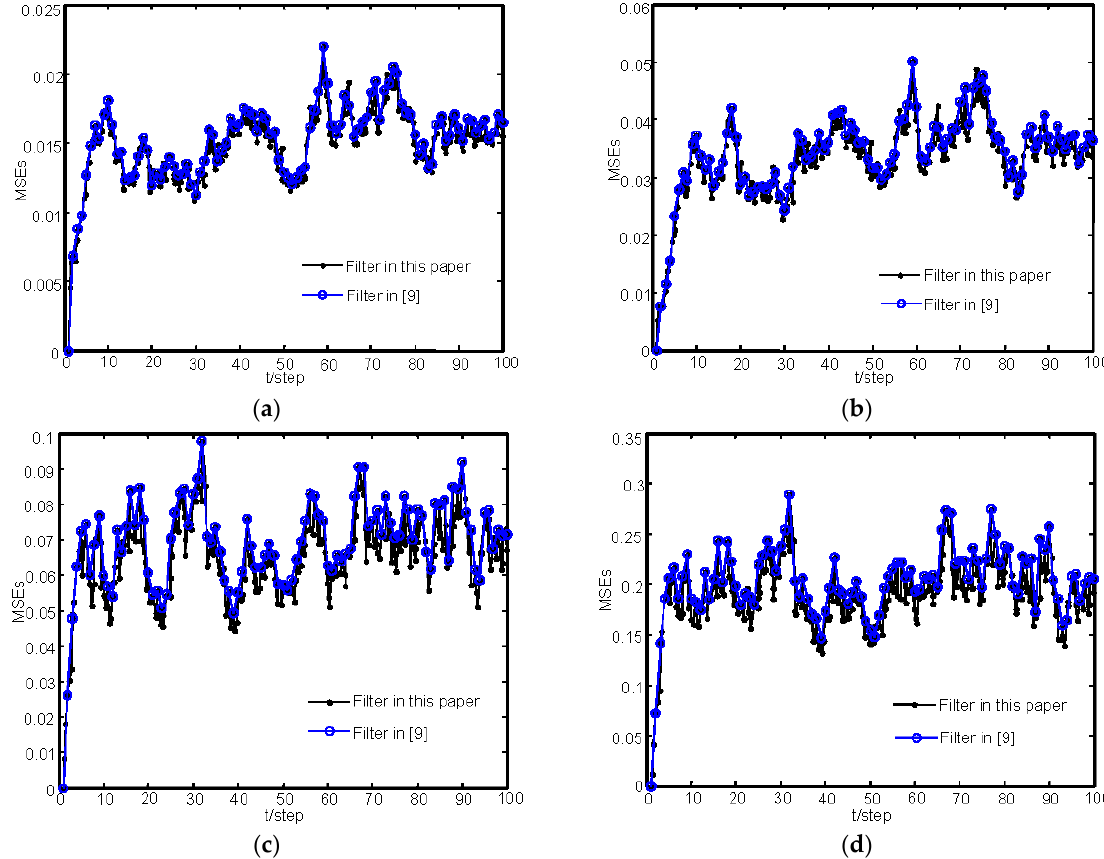
Figure 6. Comparison of MSEs of the estimators in this paper and [9] for sensor 1 without missing measurements: ( a ) MSEs of the position estimators of M 1 ; ( b ) MSEs of the position estimators of M 2 ; ( c ) MSEs of the velocity estimators of M 1 ; and ( d ) MSEs of the velocity estimators of M 2 . Table 1. Average time of 50 runs. Number of Samples Our Algorithm [9]